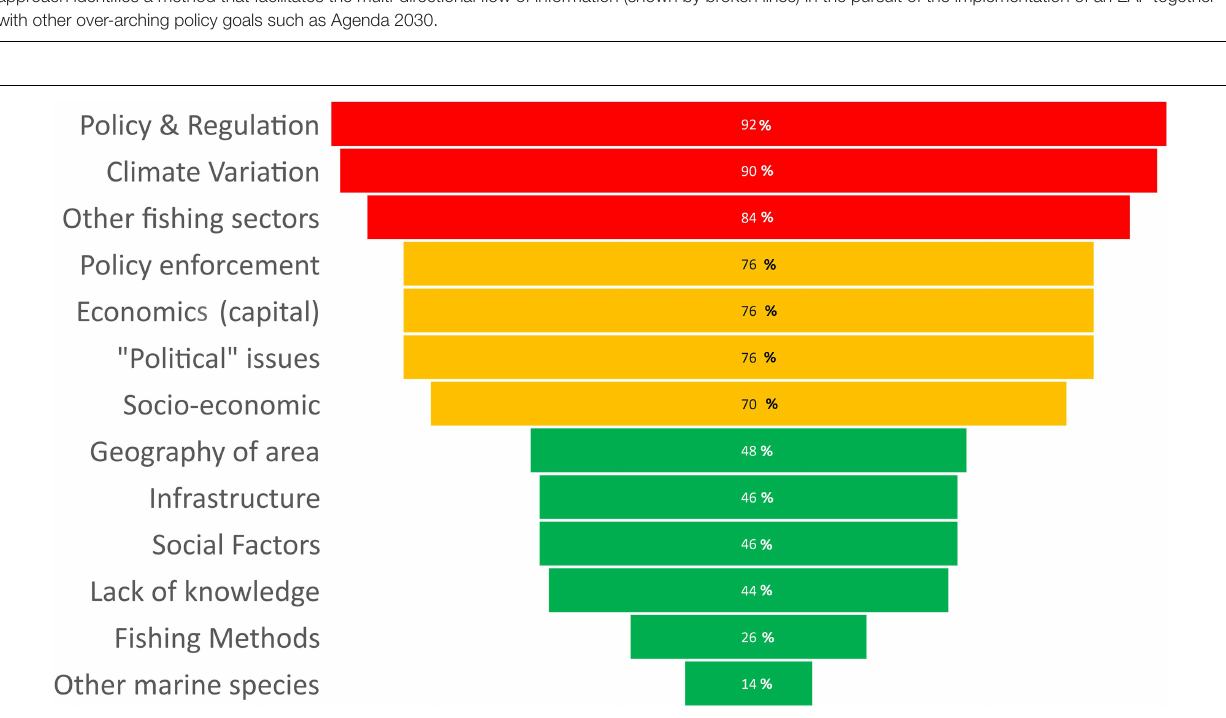
FIGURE 3 | Stressors identified be previous research carried out by Gammage et al. (2017a) and Gammage et al. (2019). The numbers are shown as percentages (%). The red colour depicts major stressors, the yellow – mid range stressors whilst the green shows the minor stressors.